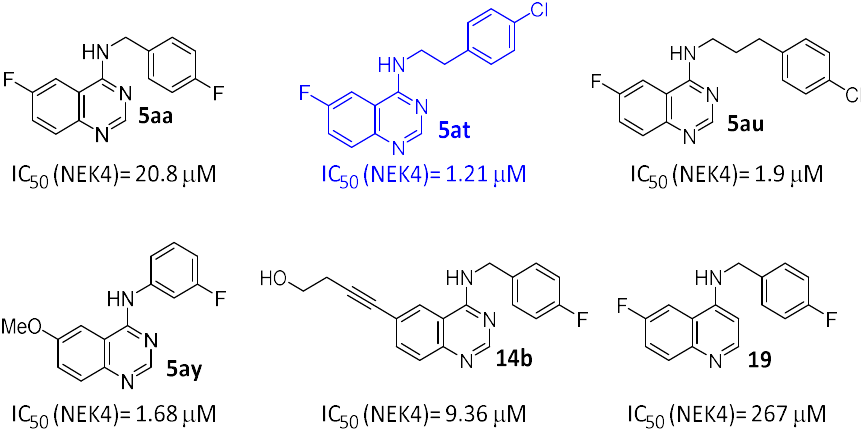
Figure 14. IC 50 values NEK4 for Spautin-1 and 5 diverse analogues (most active compound highlighted in blue).